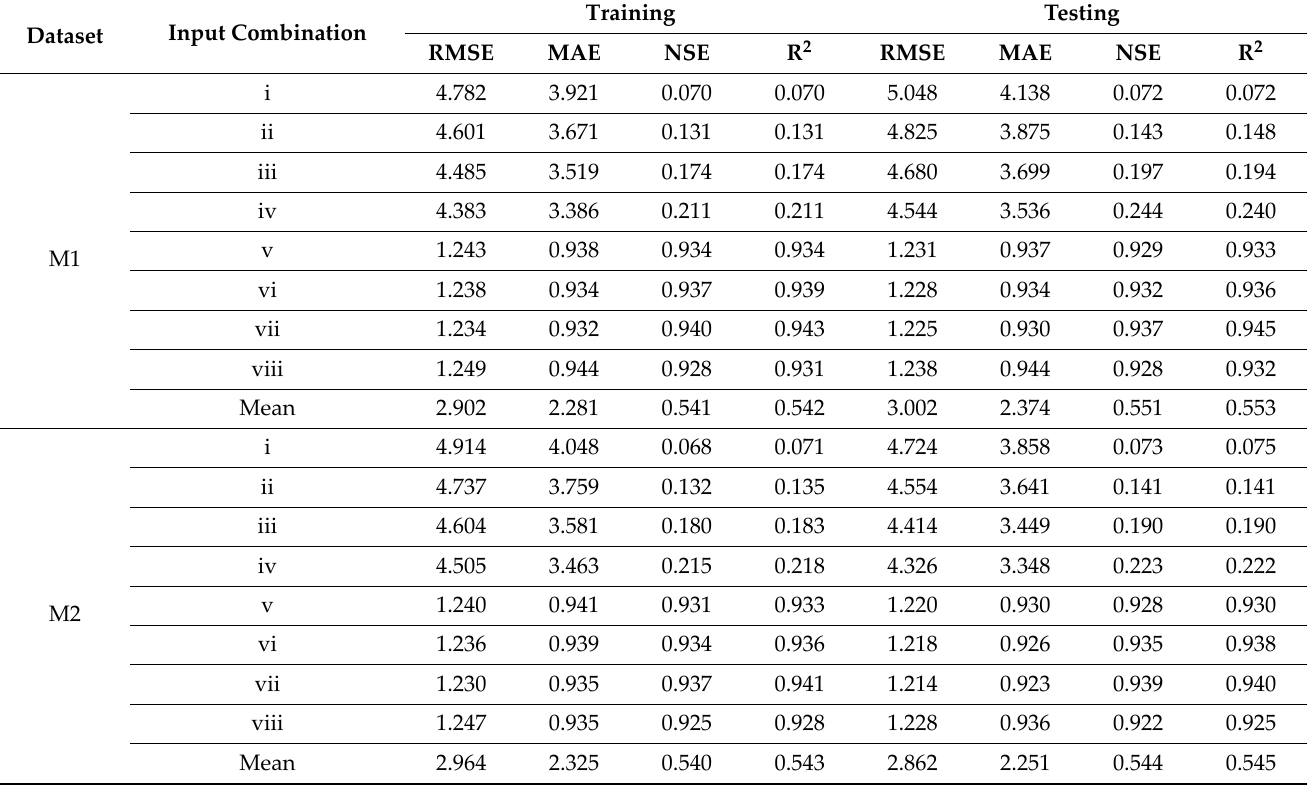
Table 9. The results of the model RVFL‑MFO for daily time